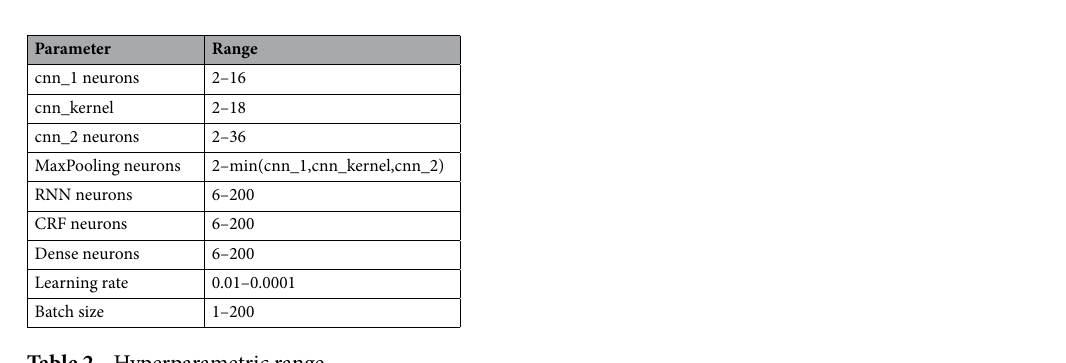
Table 2. Hyperparametric range.